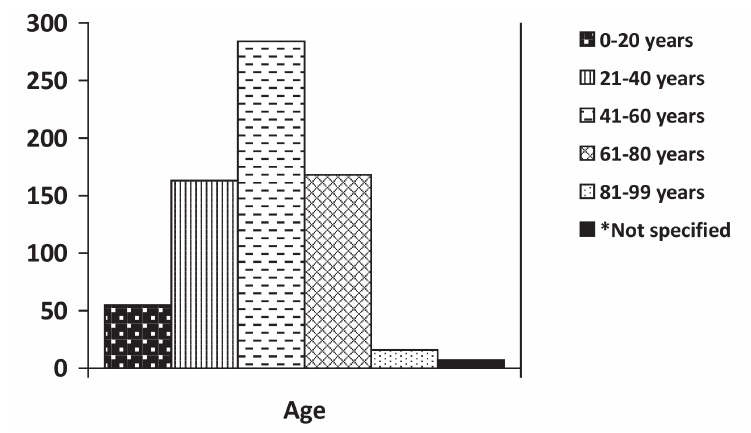
Figure 1 - Distribution of cases of onychomycosis by age in João Pessoa-PB in the period 1999 to